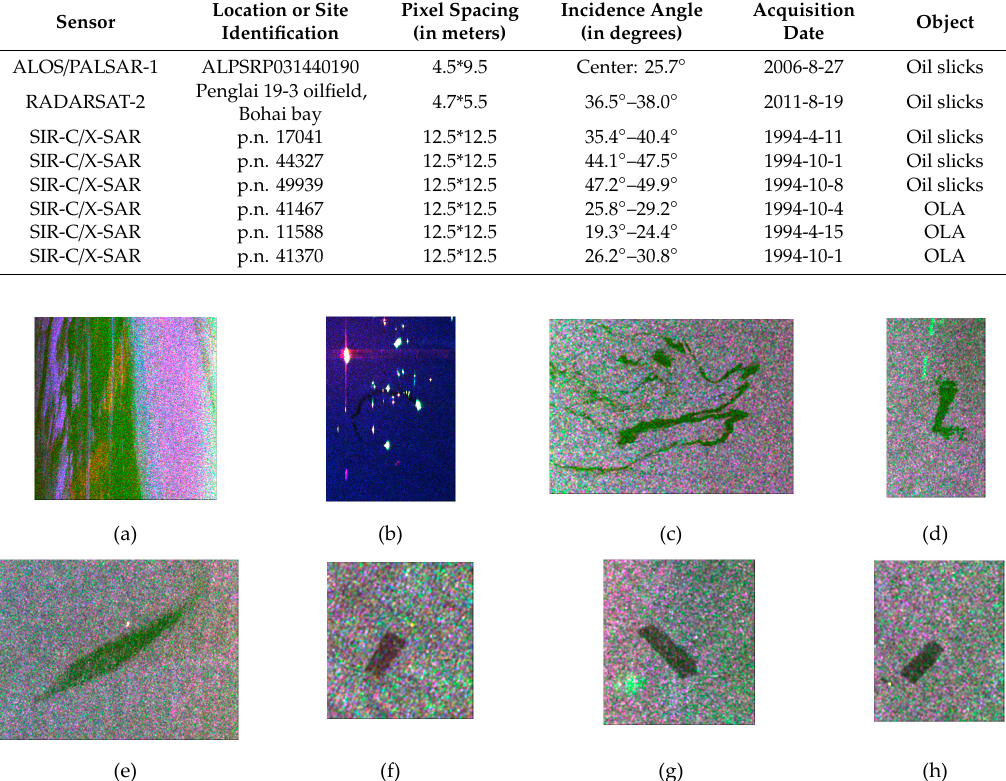
Figure 4. Pauli-basis images for oil slicks and Oleyl Alcohol (OLA). (a) ALOS/PALSAR-1 data, ALPSRP031440190; (b) RADARSAT-2 data acquired over the Penglai 19-3 oil field; (c) – (h) are SIR-C/X-SAR data sets with p.n. 17041, 44327, 49939, 41467, 11588, and 41370, respectively.